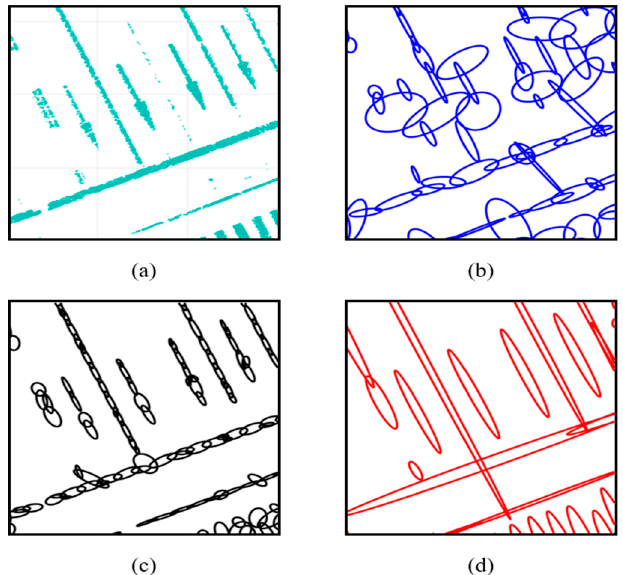
Figure 1. Comparison of probability distribution map (PDM) generation result: ( a ) Point cloud, ( b ) single resolution PDM (2 m), ( c ) single resolution PDM (1 m), and ( d ) free-resolution probability distributions map (FRPDM).